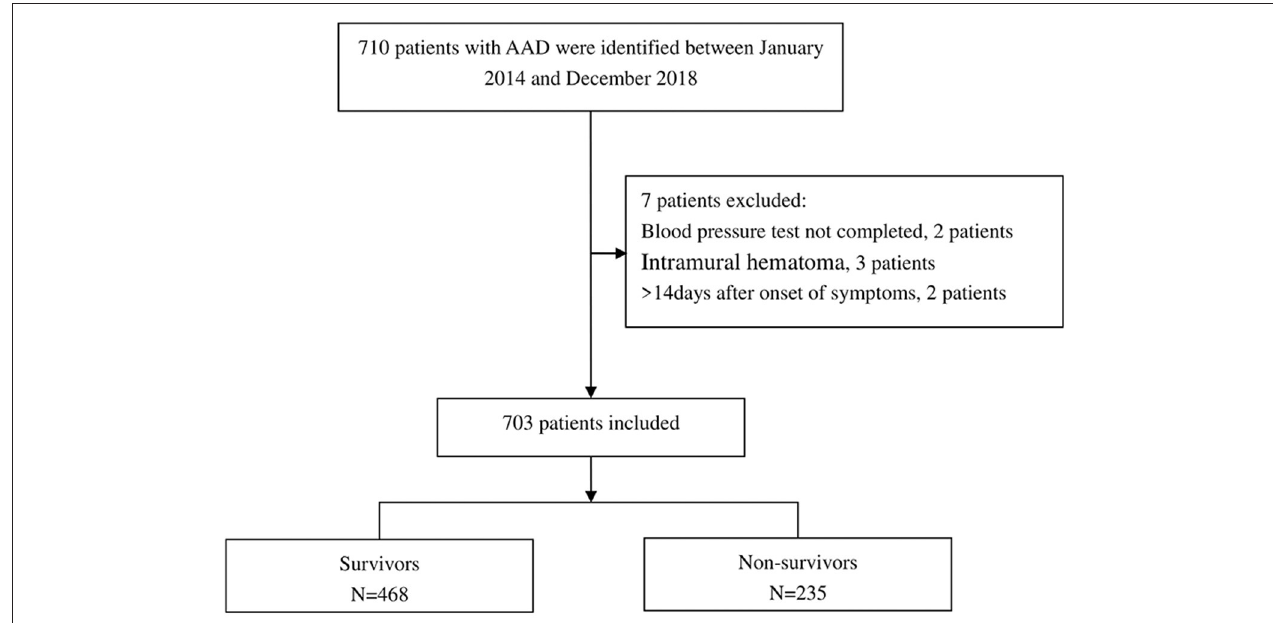
FIGURE 1 | Flow chart of patient